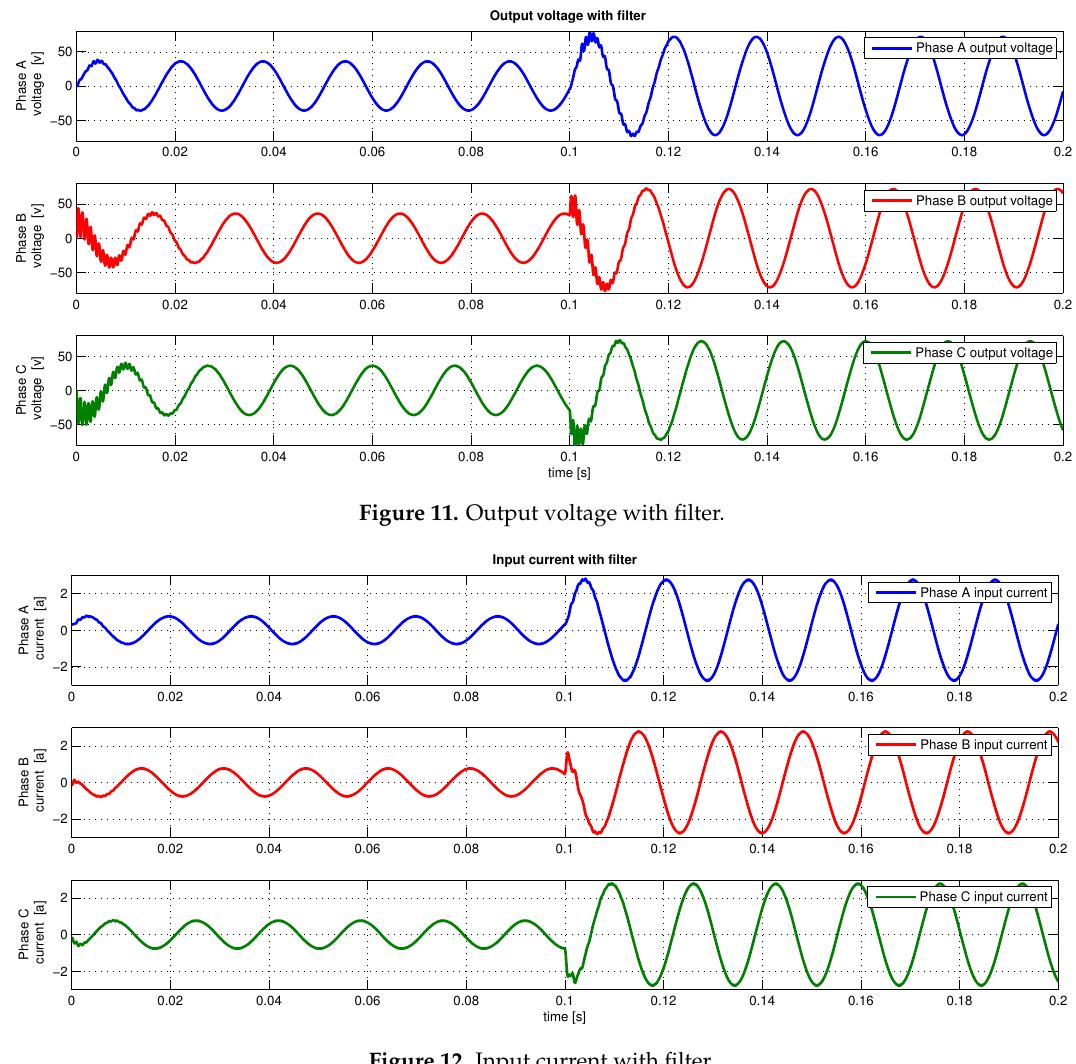
Figure 12. Input current with